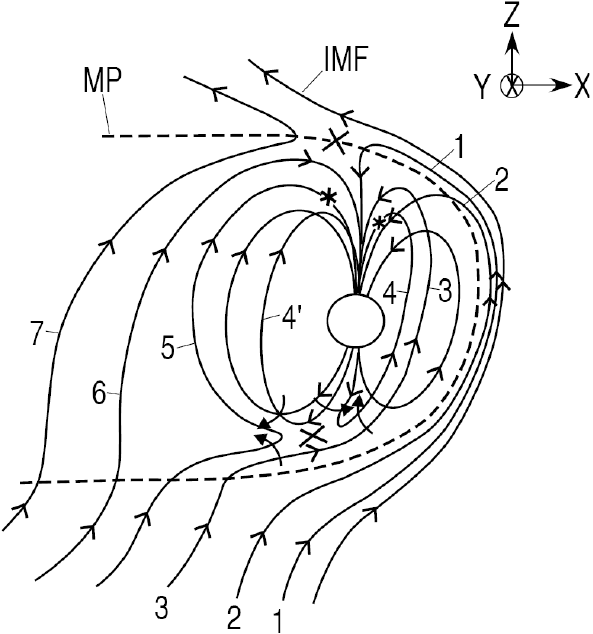
Fig. 2. Schematic illustration of convection pattern applicable to the Northern Hemisphere summer ionosphere during northeast IMF orientation ( B y = B z > 0). The coordinate system is MLT-MLAT. Latitude circles representing 70 and 80 ◦ MLAT are shown. Merg- ing and lobe convection cells are marked M and L, respectively. The dashed line marks the open-closed field line boundary. The ionospheric image of the type C reconnection in the Northern Hemi- sphere is shown. The footpoint of Polar is marked by star symbol at two times. The trajectory of spacecraft DMSP F12 during the inter- val 01:55–02:01UT is indicated. Adapted to our case after Watan- abe et al.